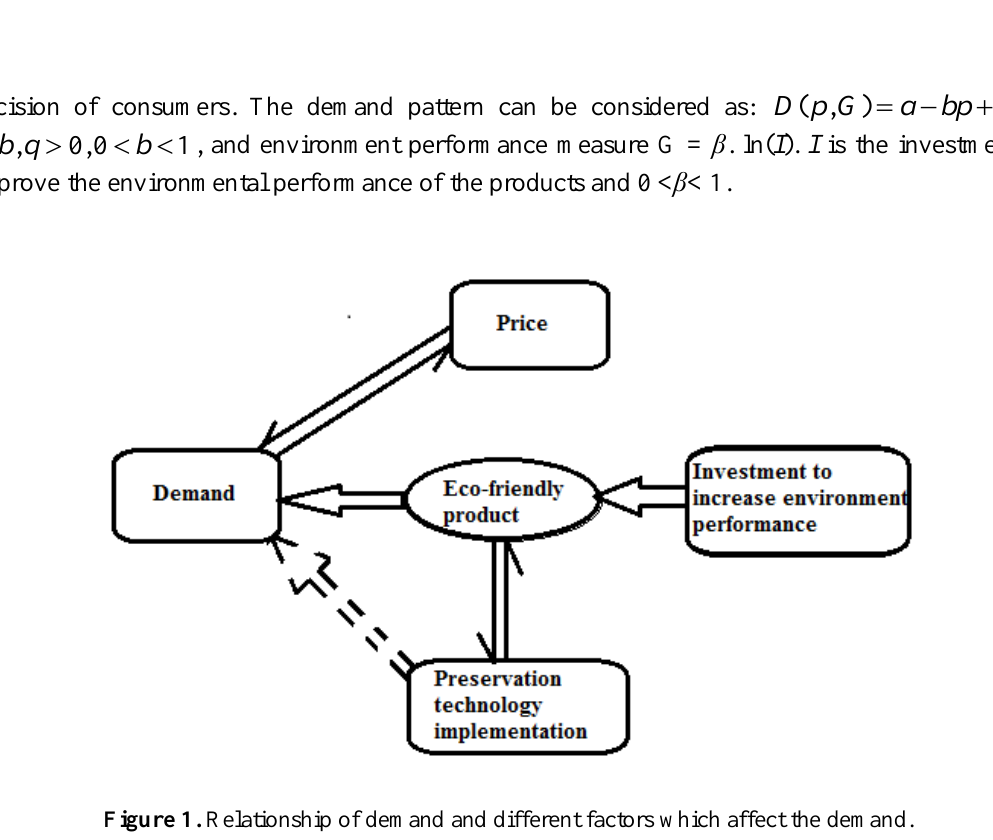
Figure 1. Relationship of demand and different factors which affect the